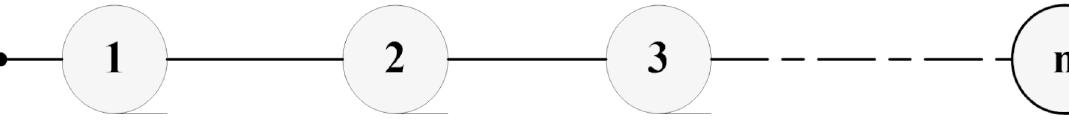
Fig. 2 Series system model